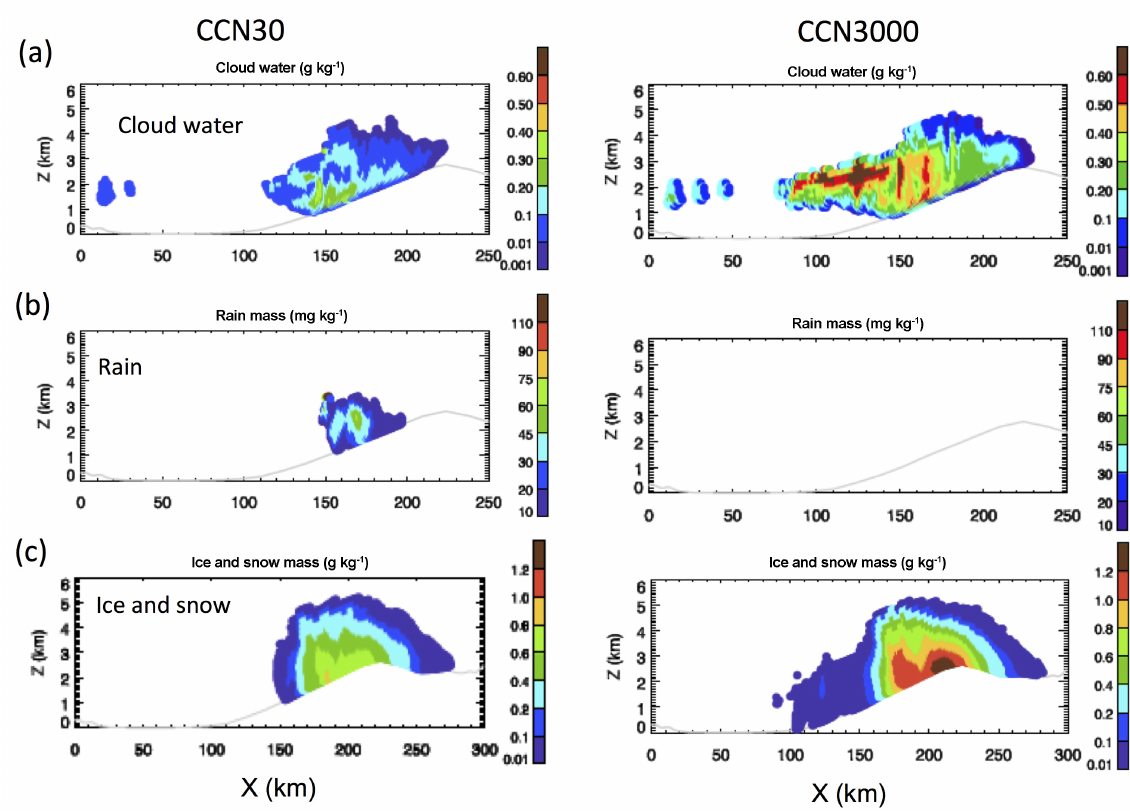
Figure 8. The west–east cross section of (a) cloud water content, (b) rain water content, and (c) ice and snow water content for CCN30 (left) and CCN3000 (right) with INP proxy concentrations of 1cm − 3 at 14:00UTC averaged over the 20km wide area zonally for the